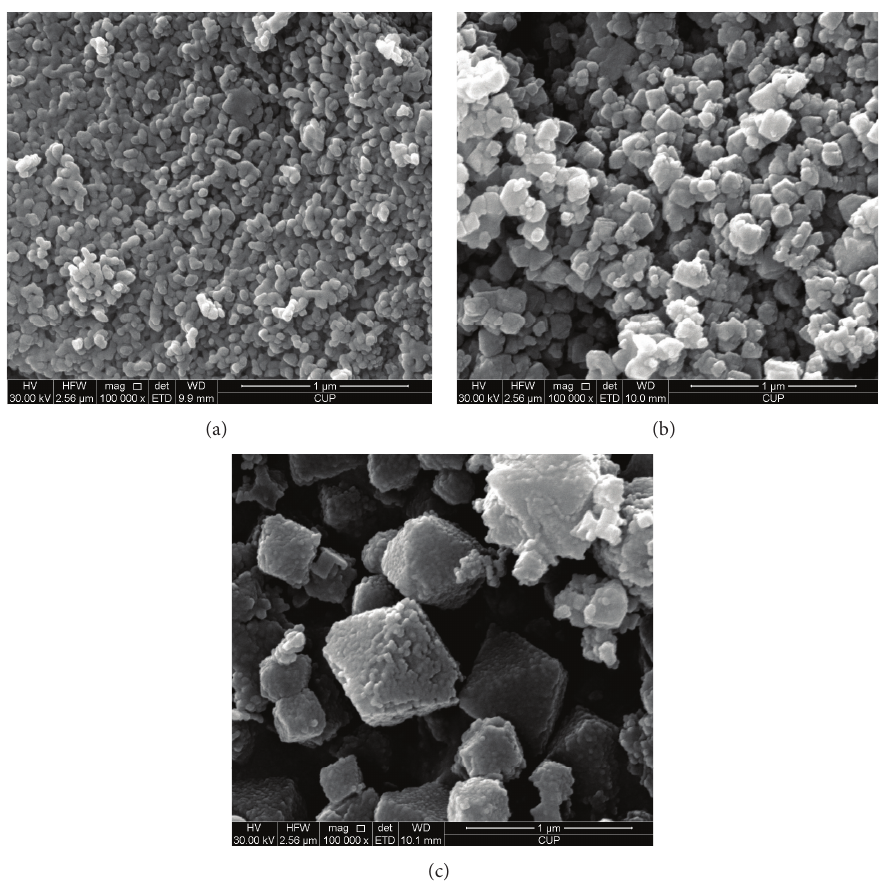
Figure 5: SEM images of the iron oxide samples. (a) FO-0, (b) FO-1, and (c) FO-2.